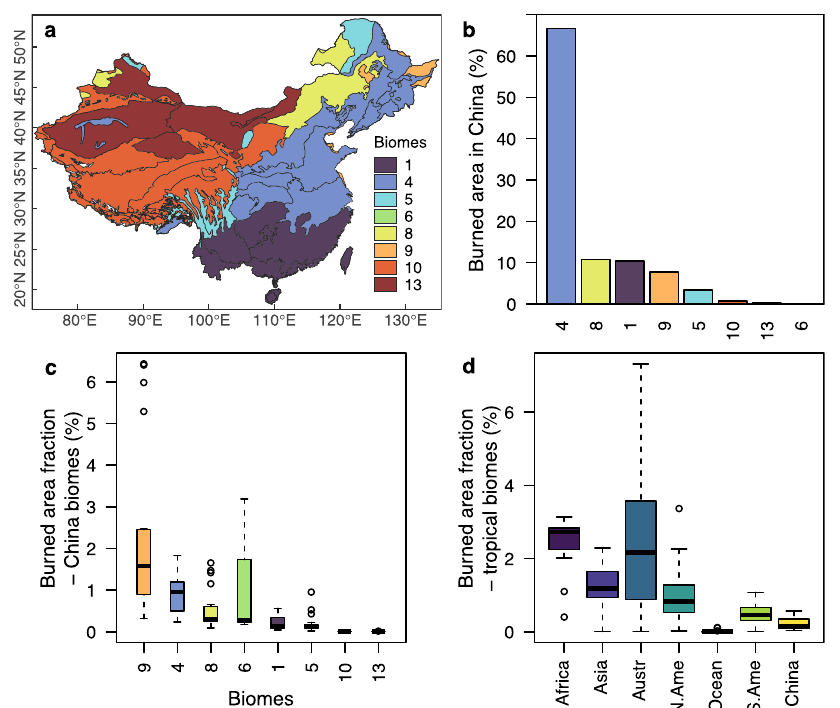
Fig. 1 | Burned area in China and in tropical biomes worldwide. a Map with China ’ s biomes. Black lines delineate ecoregions 14 . b Burned area distribution across the biomes of China from the MCD64A1 burned area product (GlobFire Database, 2001-2020) 2 . c Fraction of annual burned area, relative to the total area, for each biome in China. d Fraction of burned area across tropical forests in dif- ferent continents from Boer et al. 8 and in China. Boxplots in c and d indicate the